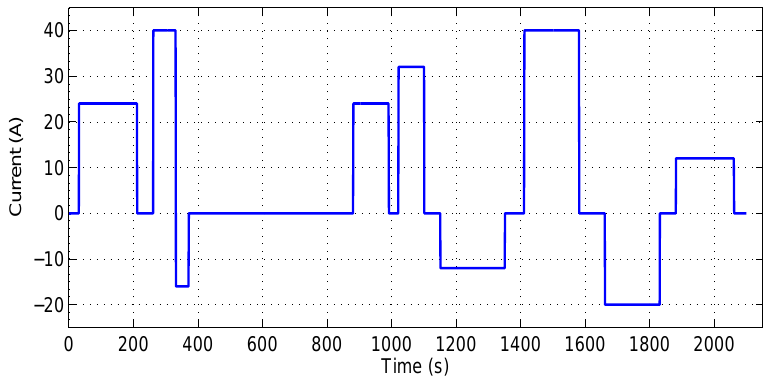
Figure 17. Different discharging/charging current rate pulses of one single cycle in hybrid pulse test.